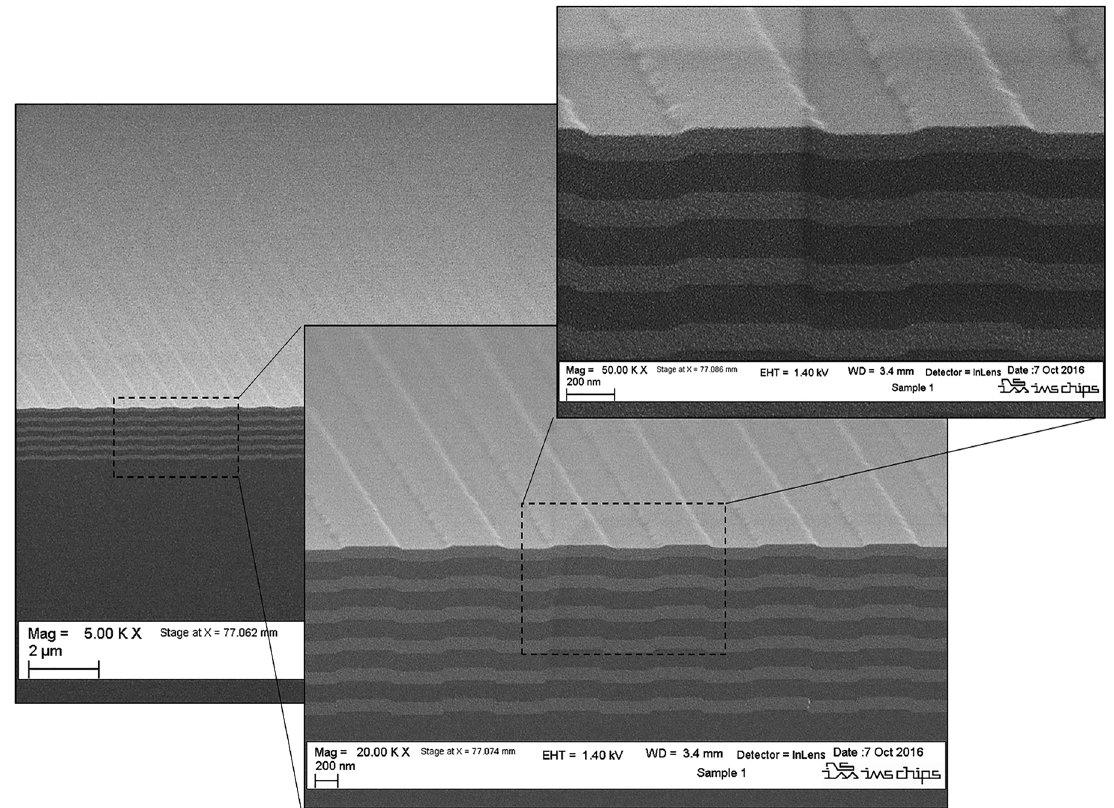
Figure 6: SEM image of a cross section through one of the fabricated